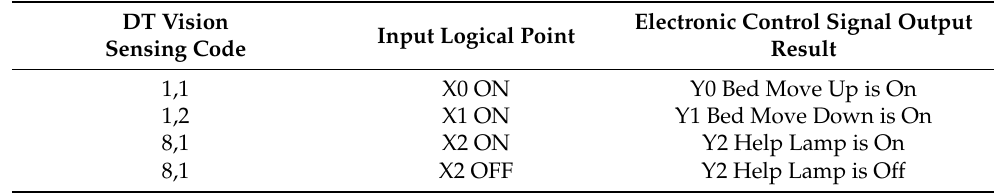
Table 2. Image Mapping to Device Control